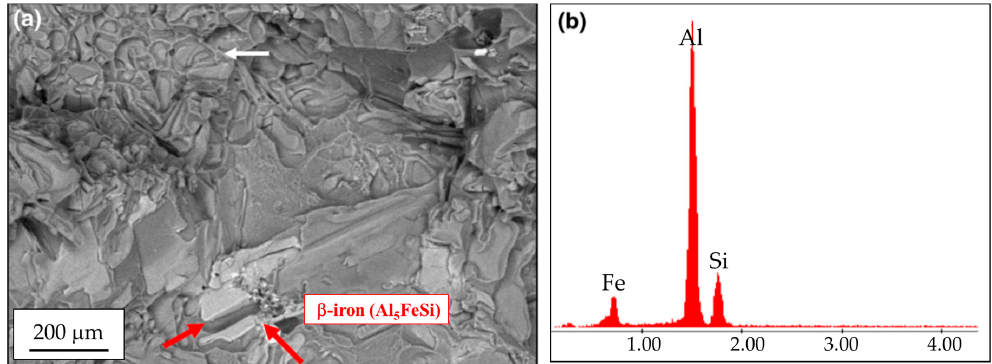
Figure 11. Scanning electron microscope analysis of the fatigue fracture surface of SSM A357 samples after T6 treatment